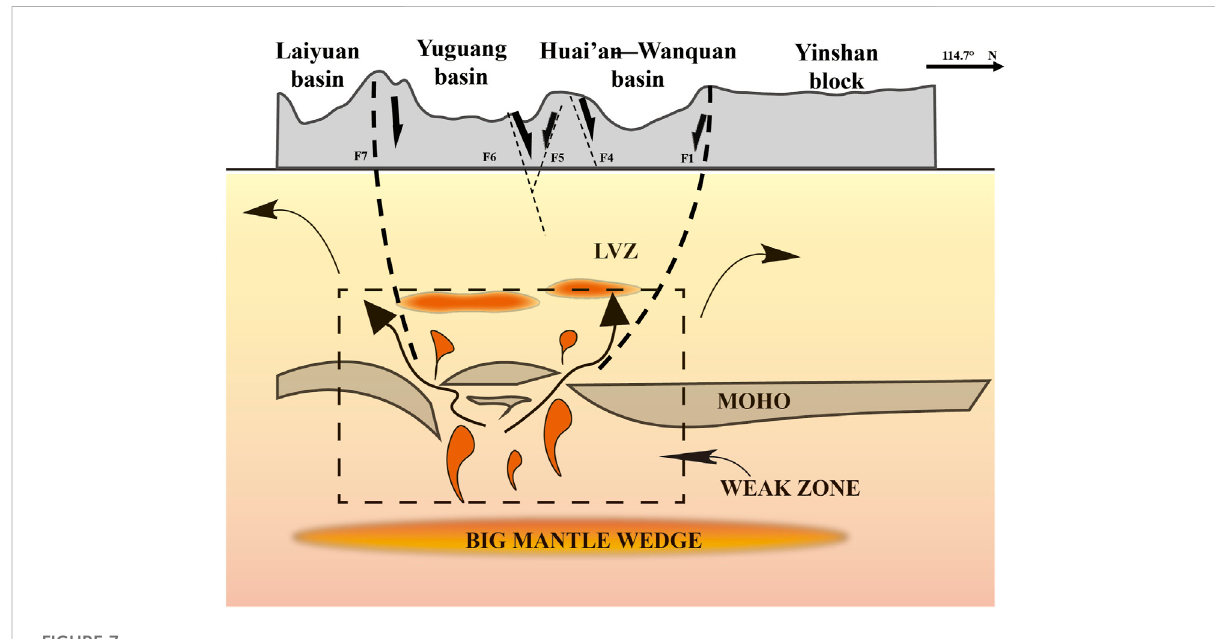
FIGURE 7 Sketched model of the interaction between the mantle and